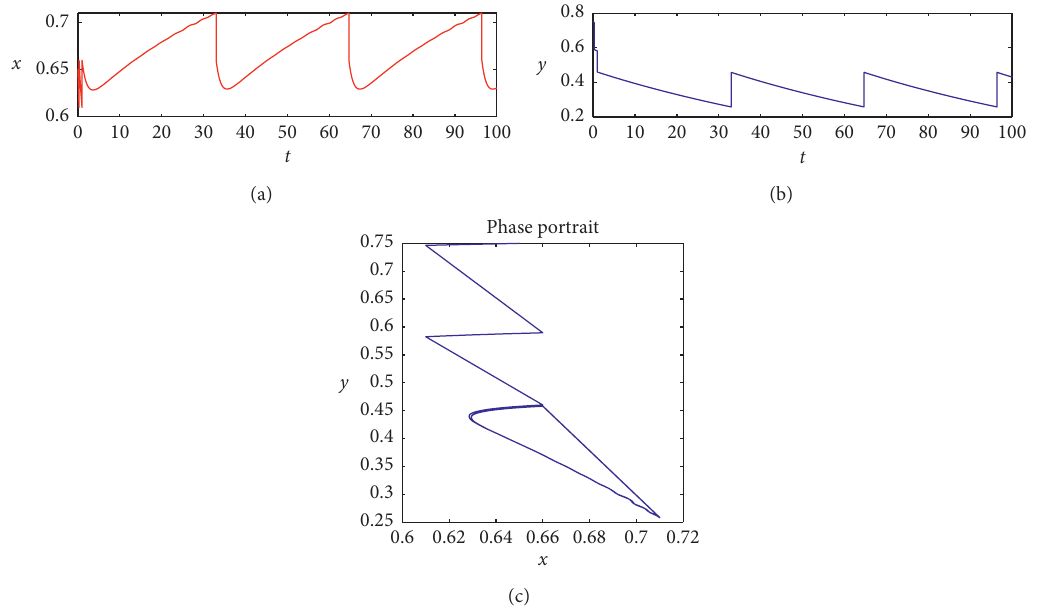
Figure 9: The order-1 periodic orbit of system (12). Control parameters: p � 0.7 and τ � 0.2.